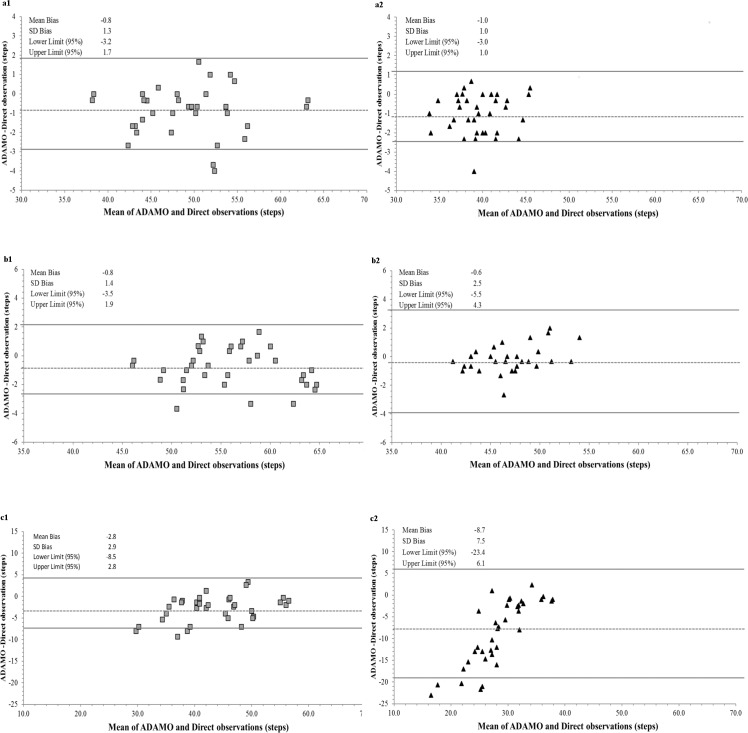
Bland–Altman plots between criterion and ADAMO Care Watch during walk test.a) Normal speed (a1 Older adults and a2 Young adults); b) Slow speed (b1 Older adults and b2 Young adults); c) Fast speed (c1 Older adults and c2 Young adults). Dashed lines represent mean bias differences; Solid lines represent 95% prediction intervals.